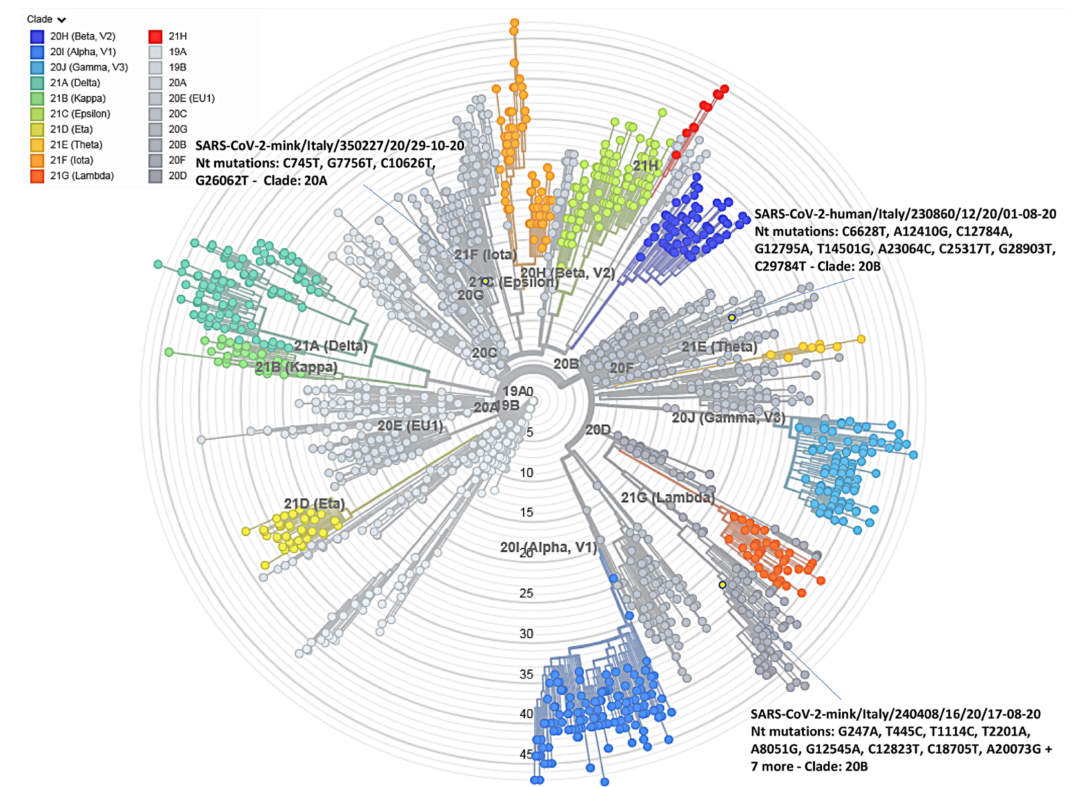
Figure 4. Maximum likelihood tree based on the complete genome SARS-CoV-2 and the three Italian sequences performed by Nextclade software. Groups are coloured according to the Nextclade assignment. Italian sequences are identified in yellow, and Nextclade assignment and nucleotide mutations are